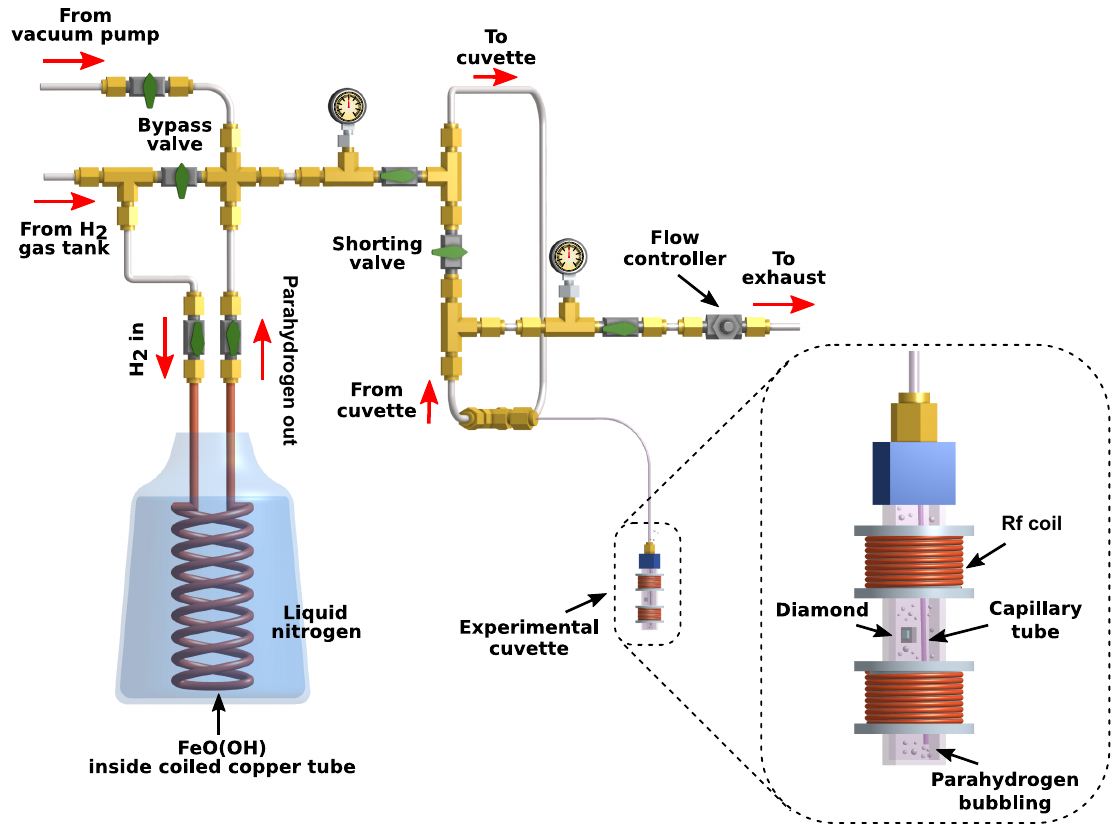
FIG. 5. Experimental apparatus for parahydrogen production and delivery to the NV-NMR setup (“experimental cuvette”). Parahy- drogen is produced by our flowing hydrogen gas through an iron oxide catalyst at 77 K. The parahydrogen is then bubbled through the capillary tube located within the experimental cuvette, where it interacts with the SABRE catalyst and hyperpolarization of the small-molecule substrate occurs. Optical NV-NMR detection is performed with a diamond chip integrated with the capillary tube in a manner similar to that previously reported [9,10]. Other key aspects of the NV-NMR setup are not shown, including the electromagnet, green laser, optics, and microwave antenna.